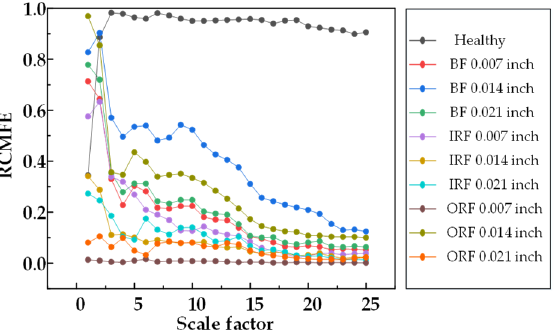
Figure 5. RCMFE entropy values of 25 scale factors under different damage degrees.